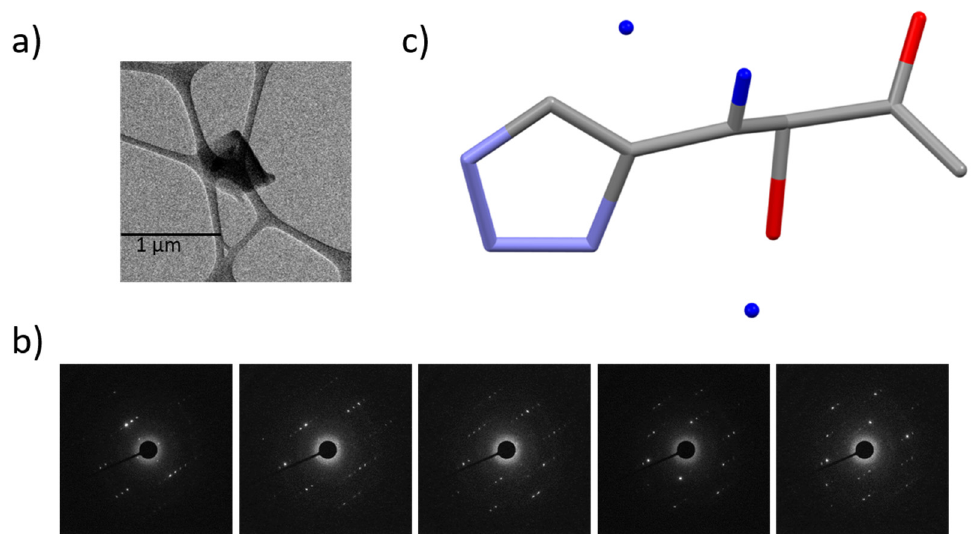
Figure 1. ( a ) TEM image of a single crystal of monoclinic L -histidine. ( b ) A set of ED patterns observed under the continuous rotation. The sample rotated 1° during each acquisition. ( c ) Initial structure solved using microED data set. The dark blue, grey, light blue, and red atoms denote H, C, N, and O, respectively.